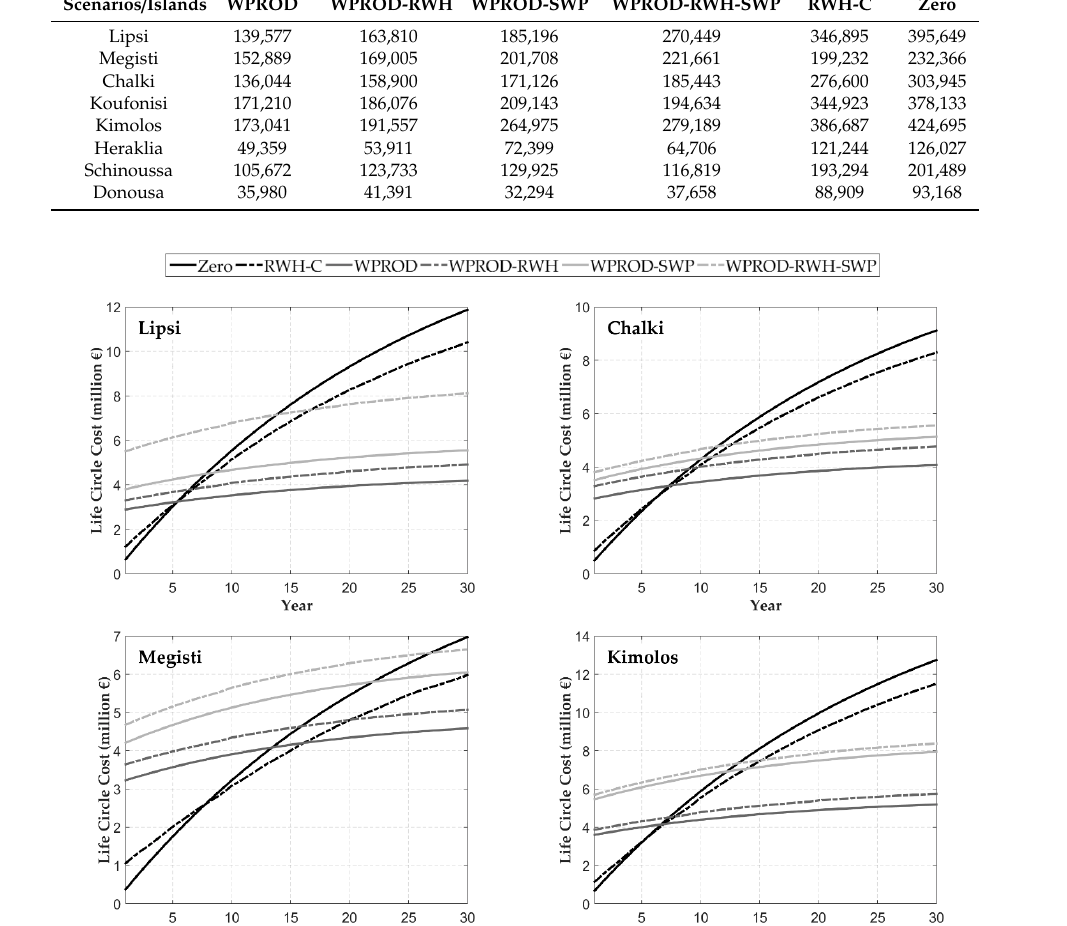
Table 6. Unit life cycle cost (LCC) for all the scenarios ( € / yr) and all the islands examined. Scenarios / Islands WPROD